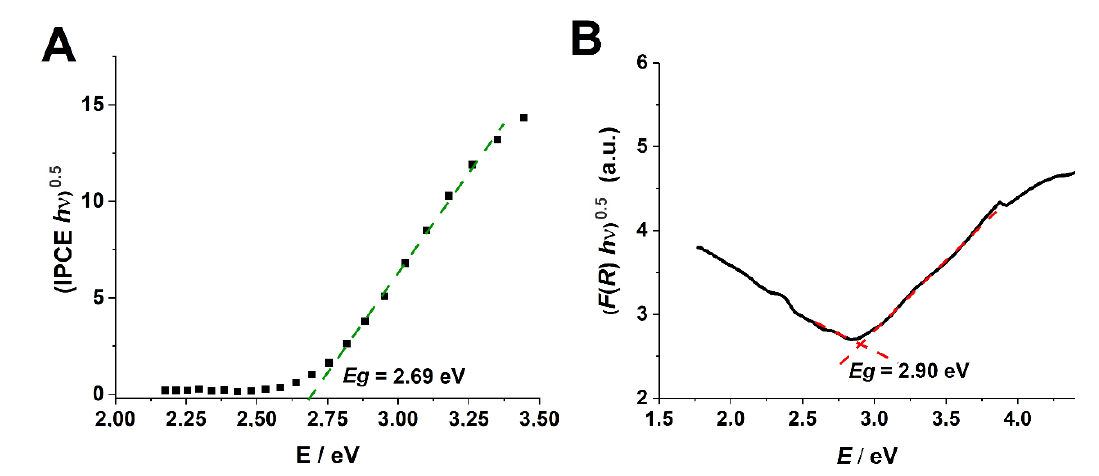
Figure 8. Band gap energy of sample B determined from (IPCE h ν ) 0.5 vs. h ν ( A ) and ( F ( R ) h v) 0.5 vs. h v ( B ) curves.